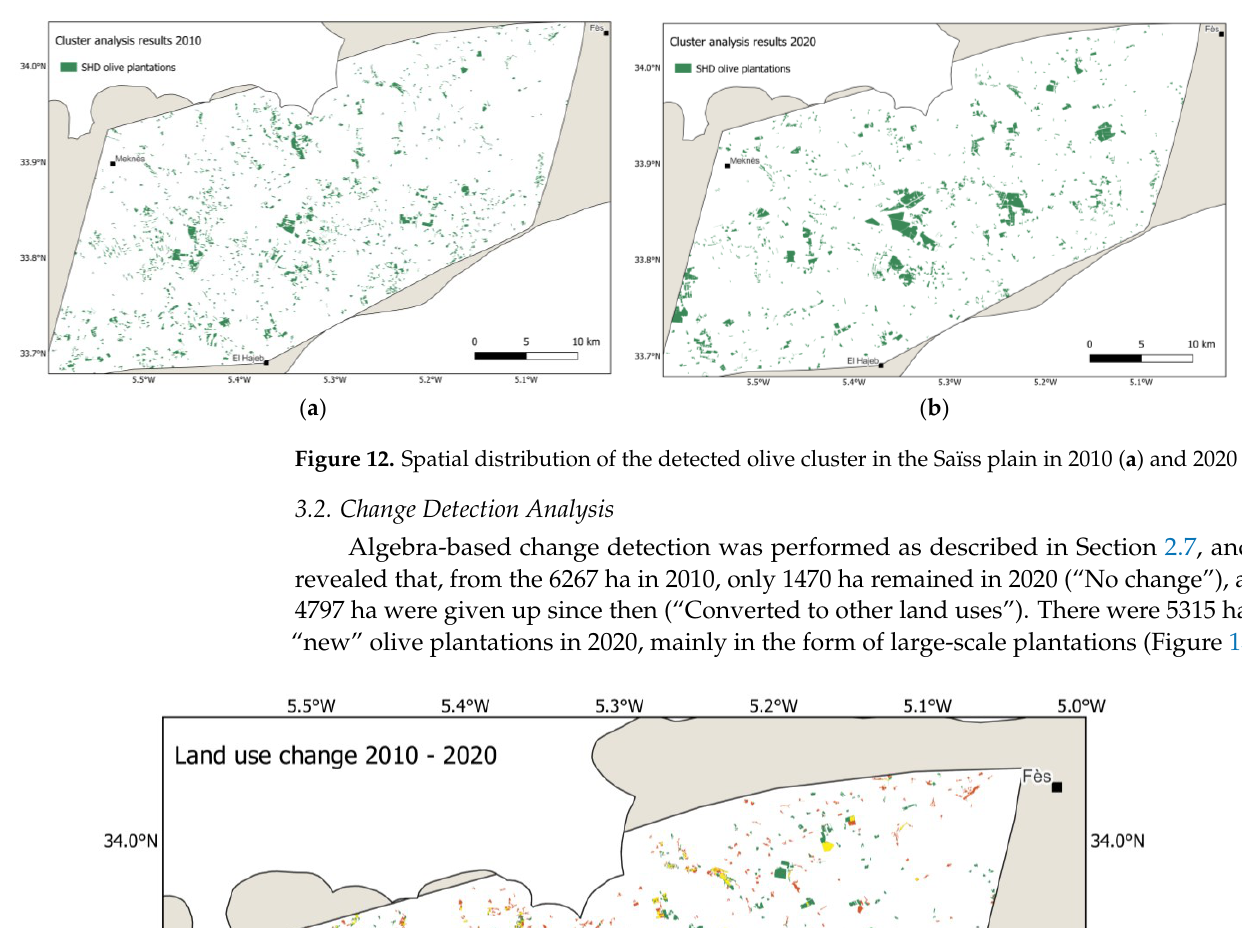
Figure 12. Spatial distribution of the detected olive cluster in the Saïss plain in 2010 ( a ) and 2020 ( b ).